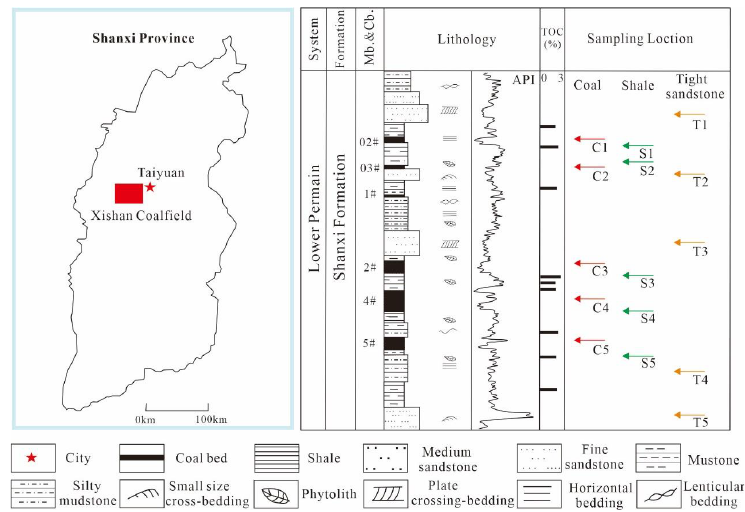
Figure 2. The study area of the Yangzhuang exploration area, the Xishan coalfield, and sampling locations of the Transitional Upper Carboniferous Shanxi Formation in Y-4 well. Table 1. Sample properties of high-rank coal, shale and tight sandstone in strata.